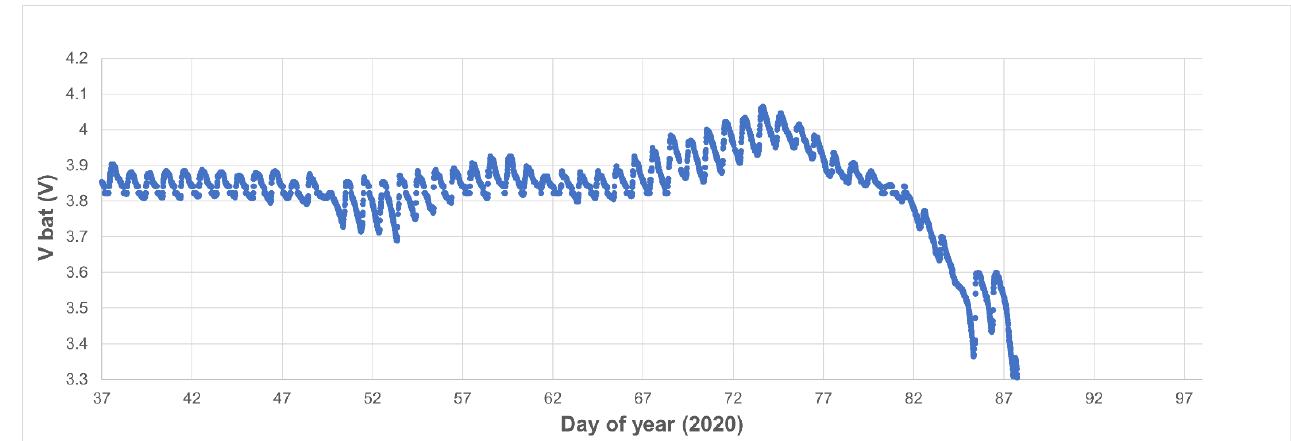
Figure 18. E volution of the battery voltage of a node with a dirty panel (node 04). Figure 18. Evolution of the battery voltage of a node with a dirty panel (node